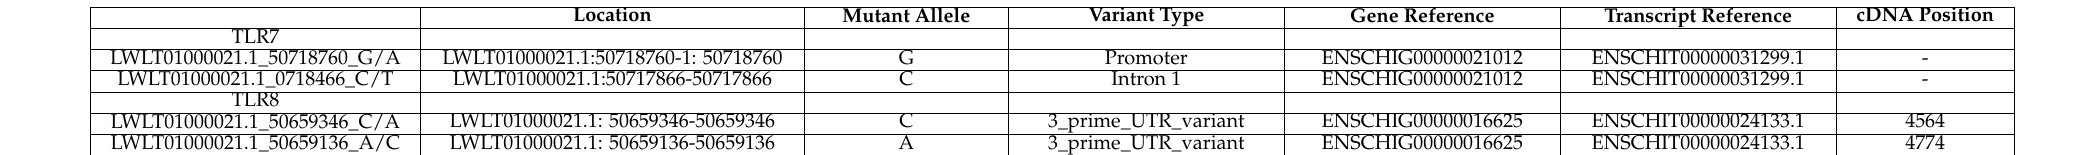
Table 3. New polymorphisms within goat TLR7 and TLR8 genes identified using Sanger sequencing